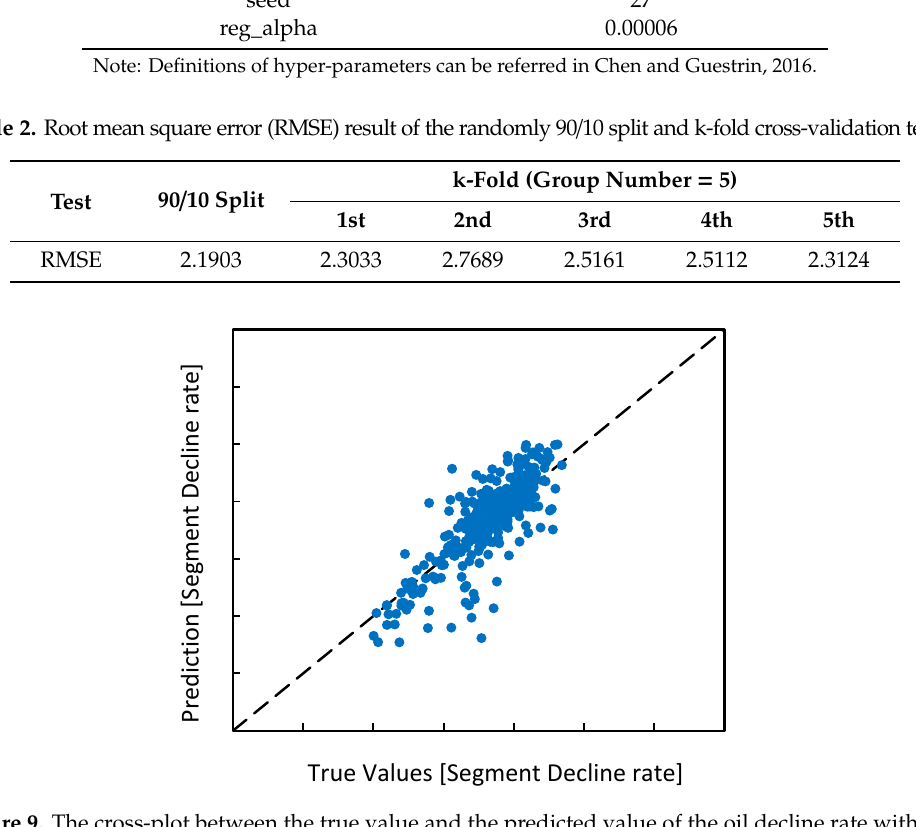
Figure 9. The cross-plot between the true value and the predicted value of the oil decline rate with the 90/10 split.